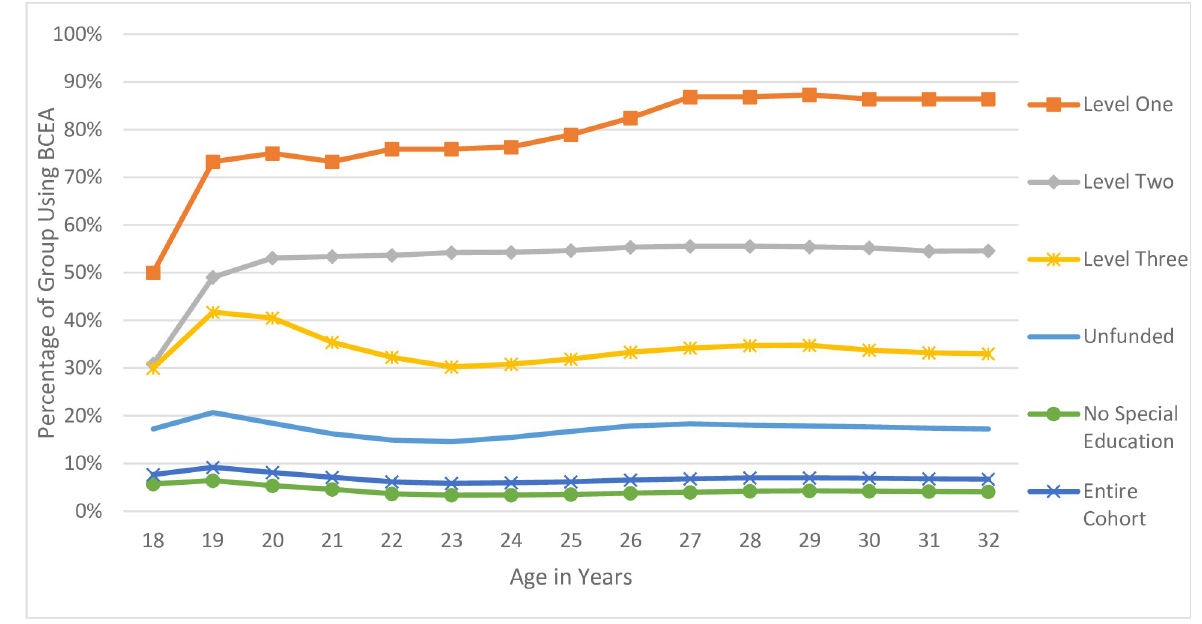
Fig 1. Receipt of BCEA support among those previously using special education support. Percentage of individuals within each special education group who received British Columbia Employment and Assistance program (BCEA) support during the fiscal year, by age.